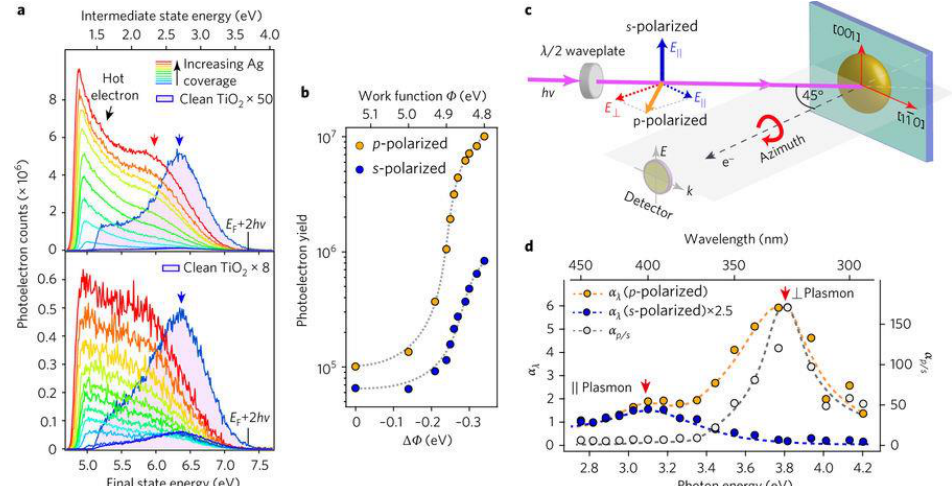
Figure 11. Characterization of Heterojunction Plasmons. ( a ) Deposition of Ag onto TiO 2 is shown to enhance 2PP yields and consequently modifies the spectra of the s- and p- polarized excitations. The work function of the sample is noted to decrease around 0.35 eV, shifting the onset photoemission energy. ( b ) The 2PP yields are determined by integrating the photoelectrons counts with respect to the final photoelectron energy E f and are plotted as a function of the change in the work function, which is dependent on the depth of Ag coverage. ( c ) A schematic portraying the enhancements of the 2PP yield with respect to the incident laser wavelength polarization and crystal azimuth orientation. p -polarized light has both the parallel and perpendicular electric field components, while the s -polarized light consists only of the parallel component. ( d ) Wavelength dependence of the 2PP enhancement by the parallel and perpendicular plasmon modes at energies 3.1 and 3.8 eV. This is determined by taking the ratio of p- to s- polarization yields (right y axis) and Ag/TiO 2 to Mo (a polycrystalline Molybdenum sample that assumes a flat spectral response) yields. Reprinted with permission from Ref [161] Copyright Springer Nature (2017).